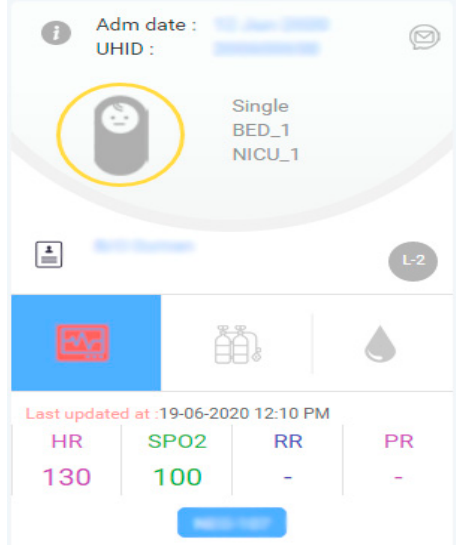
Figure A8. Baby placard notifying the disconnection of sensor capturing physiological data (the red icon is flashed continuously until the physiological data resumes).